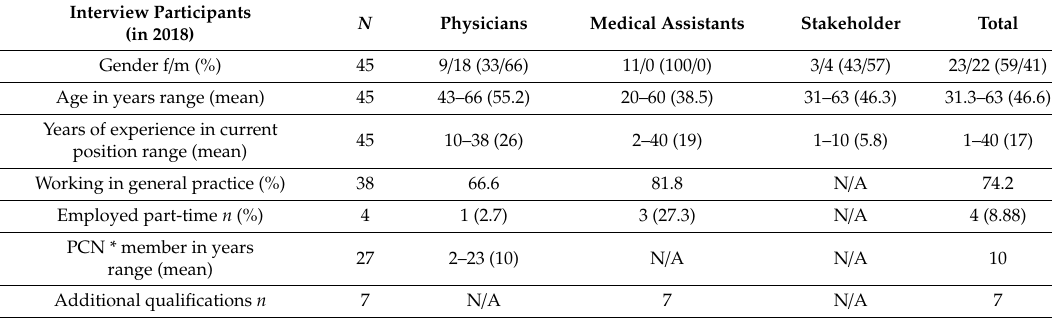
Table 2. Characteristics of the interview